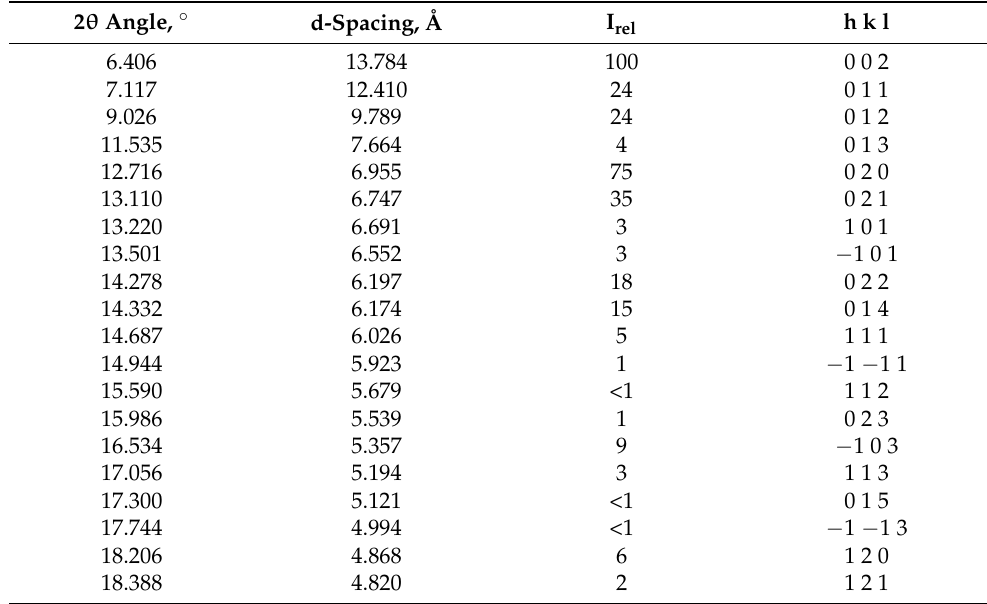
Table 8. List of observed 2 θ angles, d-spacings, and relative intensities, jointly with reflection indices, for Eltrombopag DMF solvate.